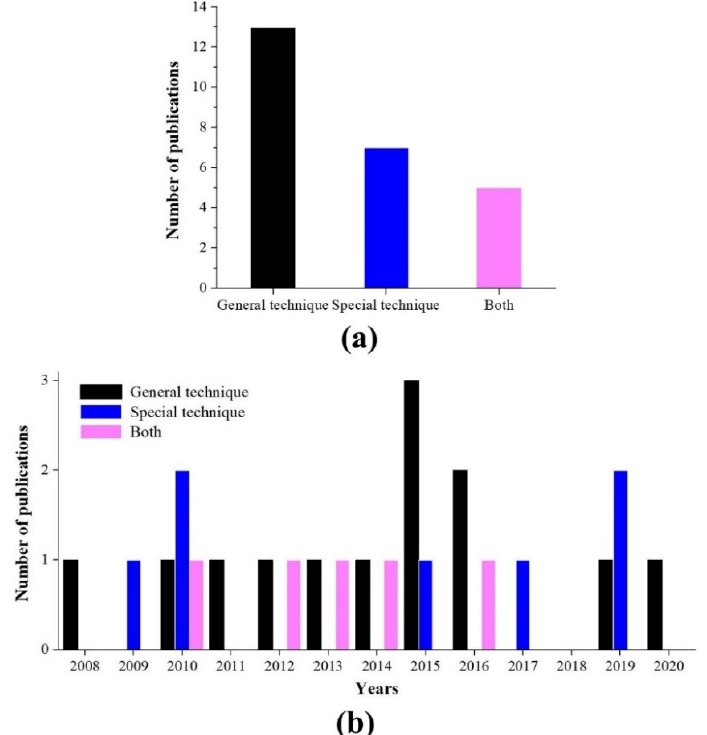
Figure 4. ( a ) Graph of the number of publications for the various MR image acquisition techniques using the NLM noise reduction algorithm. The final classification included 25 papers; of those, three major categories of techniques were investigated. ( b ) The total number of papers as a function of the publication year.